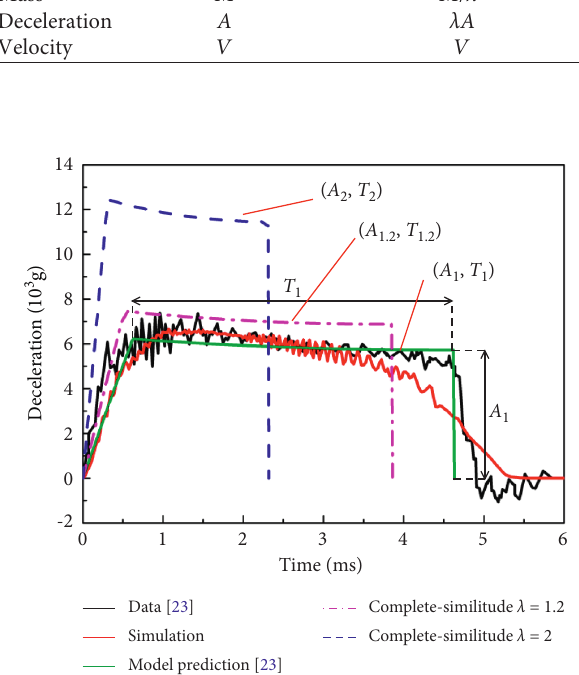
Figure 1: Deceleration-time data and model prediction with different scaling factors for projectiles penetrating the concrete target ( f c �